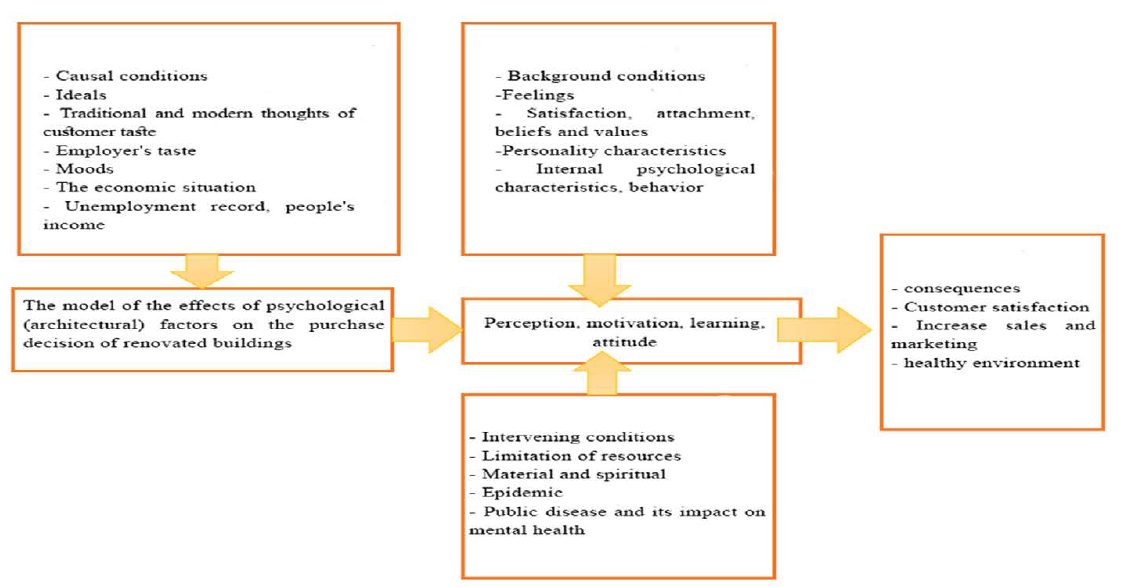
Fig. 1 : The primary model of psychological (architectural) factors on the purchase decision of renovated buildings